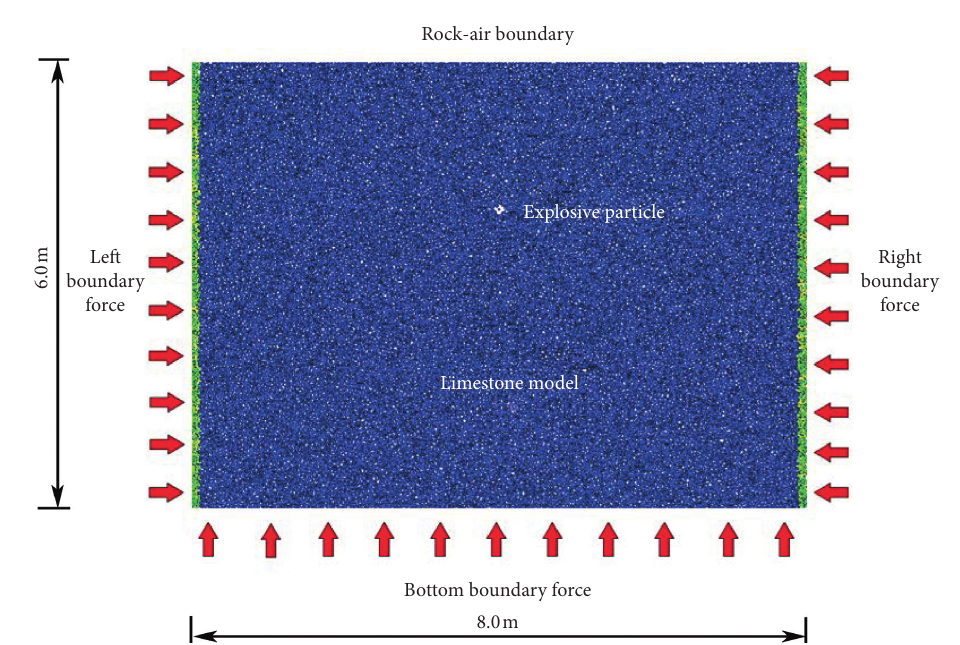
Figure 1: Limestone particle flow code